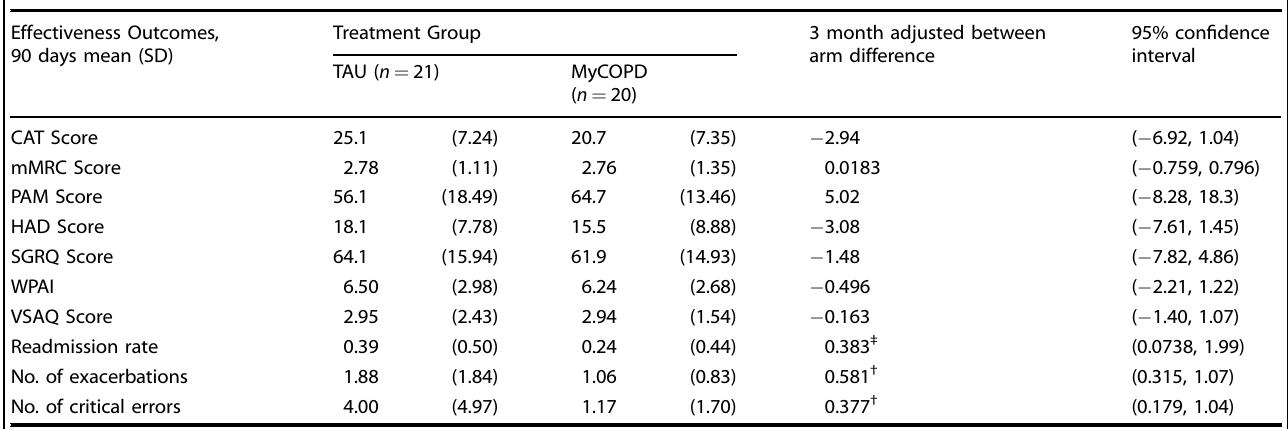
Fig. 3 Standardised CAT score by trial arm over time. Indicated is the mean standardised CAT scores over the 3-month study in both the Treatment as Usual (Red) and MyCOPD App (Blue) arms. 95% con fi dence intervals are shown in light grey. Table 5. Effectiveness outcome at 90 days by arm and adjusted mean